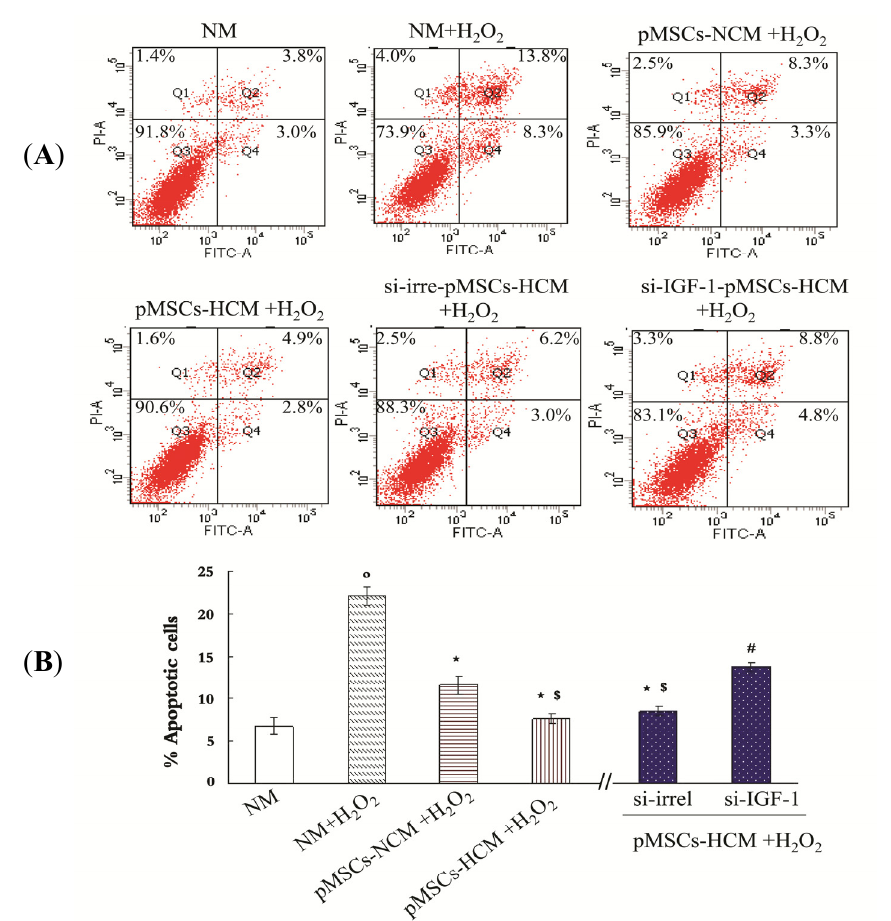
O -treated- 2 2 O -treated caco2 cells in NM, 2 2 O ; $ p < 2 2